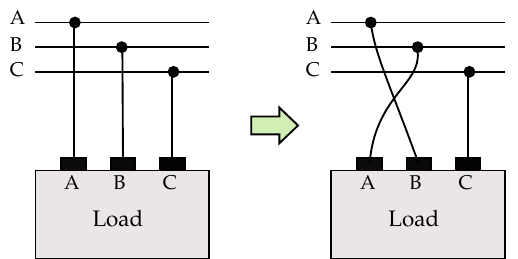
Figure 1. Phase-swapping according to type of